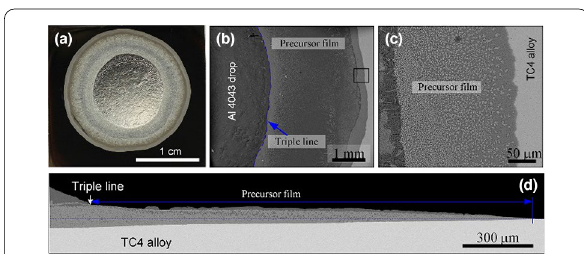
Figure 4 Appearance of representative sessile drop samples and cross-sectional view of Al-Si/Ti6Al4V system after isothermal wetting at 650 °C: ( a ) sessile drop samples, ( b ) top view of PF, ( c ) details of rectangle in ( b ), and ( d ) cross-sectional